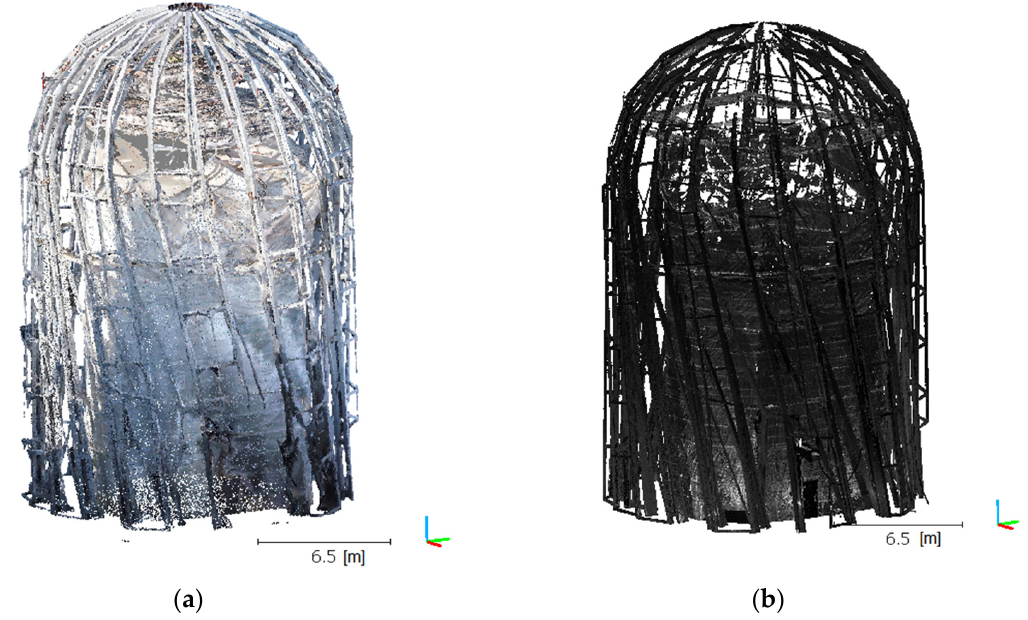
Figure 7. Point clouds after removing the ground and accompanying objects for UAV ( a ) and TLS ( b ).